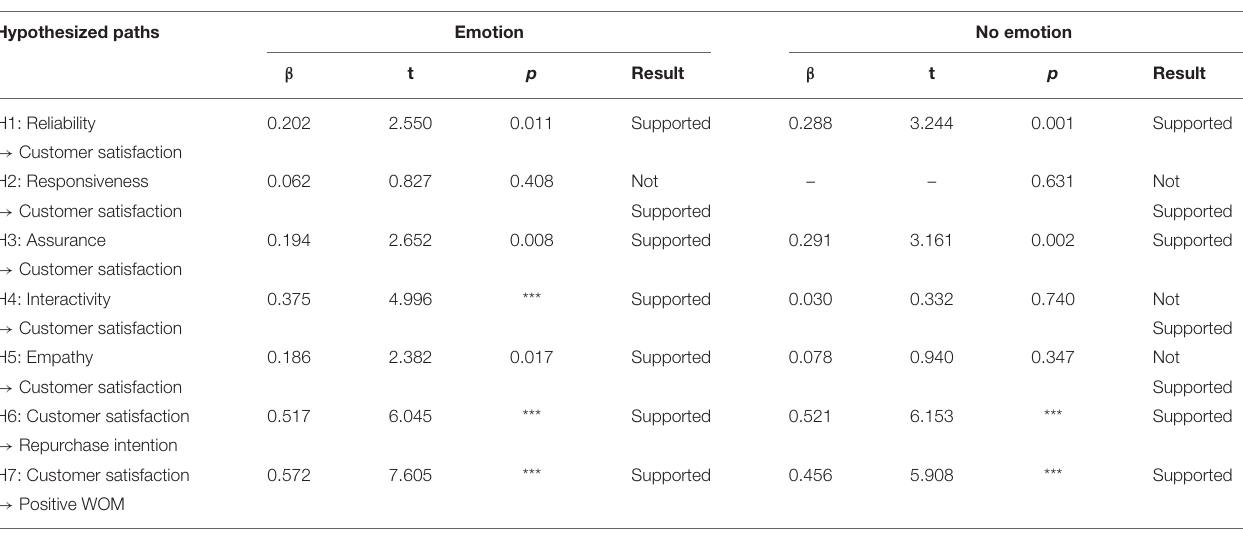
TABLE 5 | Results of structural equation